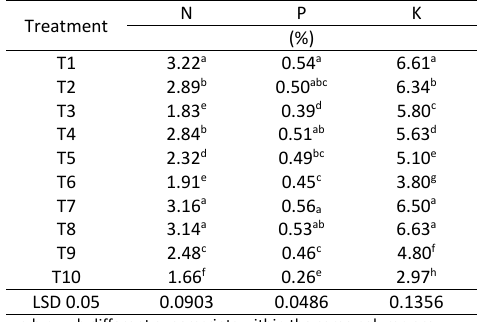
Table (5): Effect of biofertilizers on macronutrients content in celery Table 5. Effect of biofertilizers on macronutrients content in celery Treatment